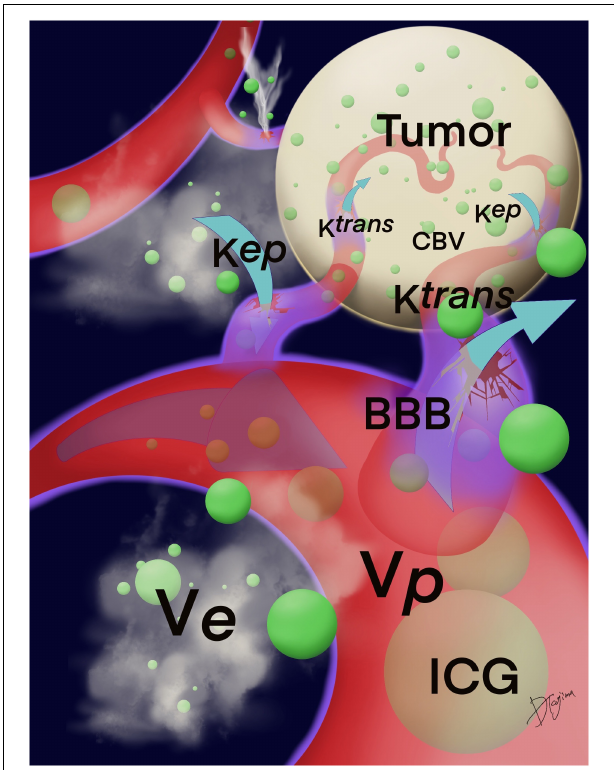
FIGURE 1 | Schema of K trans , K ep , V e , and V p . K trans indicates the permeability from the intravascular to the extravascular space; K ep , from the extravascular to the intravascular space; V e , the volume of the extravascular extracellular space; and V p , the fractional plasma volume. The BBB around the tumor was damaged, and ICG may leak from vascular structures at the compromised BBB that were calculated by the permeability. Green circles are ICG particles. BBB, blood–brain barrier; ICG, indocyanine